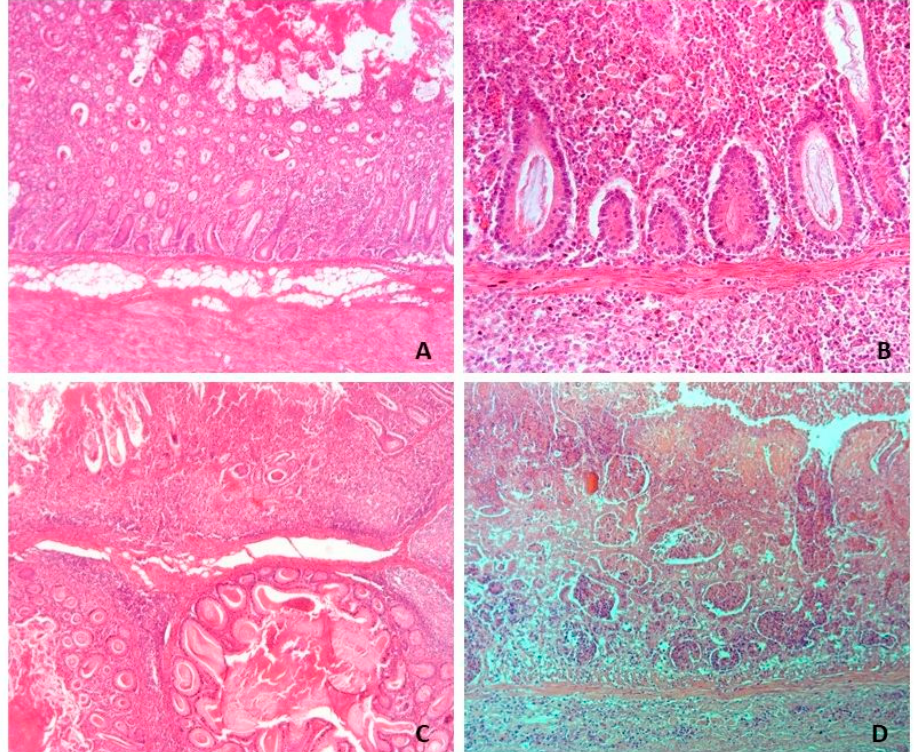
Figure 4. Swine ileum, ( A , B ) Case ID 2: Proliferative haemorrhagic enteropathy (PHE). Necro- haemorrhagic content in the lumen is associated with moderate crypt hyperplasia and mucosal expansion by numerous lymphocytes, plasma cells and histiocytes intermixed with extravasated erythrocytes. In ( B ), crypts with absent differentiated (goblet) cells are shown. ( C ) Case ID 1: PHE; Crypt hyperplasia and herniation in the submucosa. ( D ) Case ID 3: Necrotic enteritis (NE); Necrosis of the mucosa above muscularis mucosae and cell infiltration in the submucosa. ( A , C ): 6.3×. ( B ): 25×. ( D ): 16×.